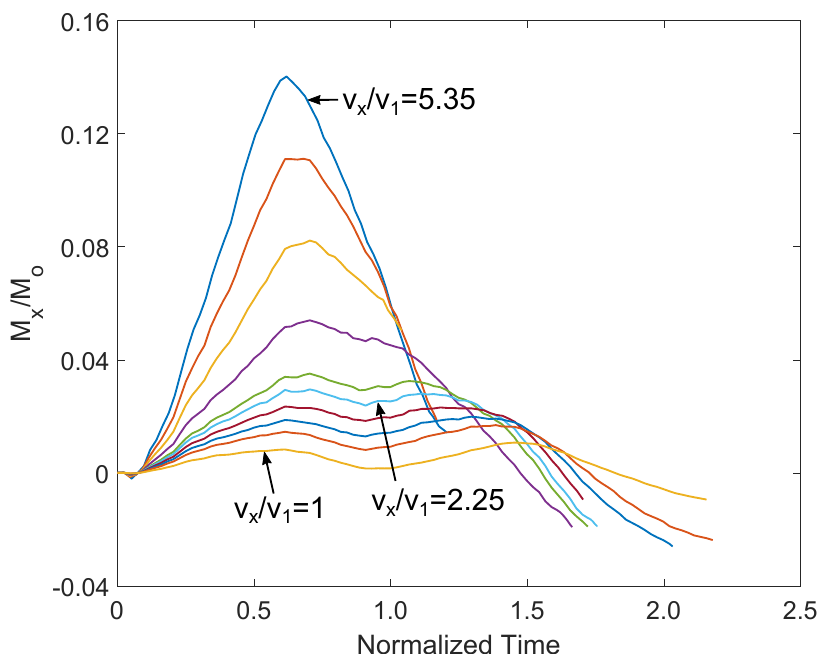
Figure 6. Normalized bending moment at x -direction at the fixed end of the blade, with respect to normalized time, for the different velocities of the killer whale.